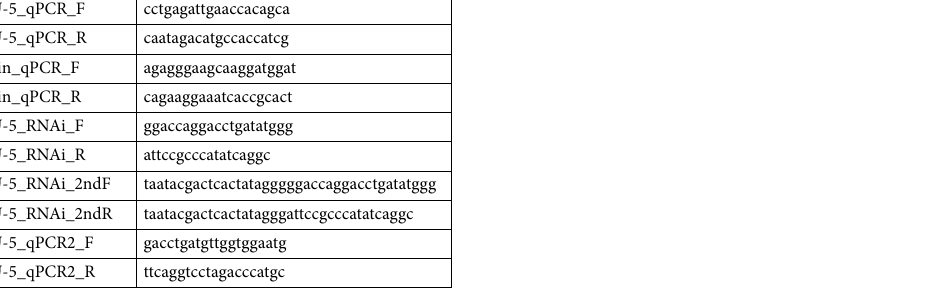
Table 3. Sequences of